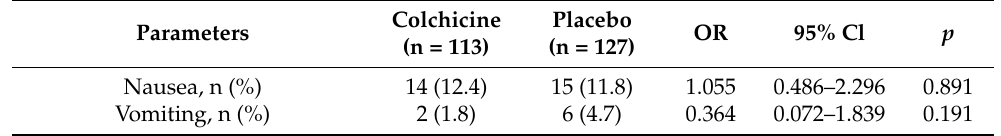
Table 7. Adverse clinical